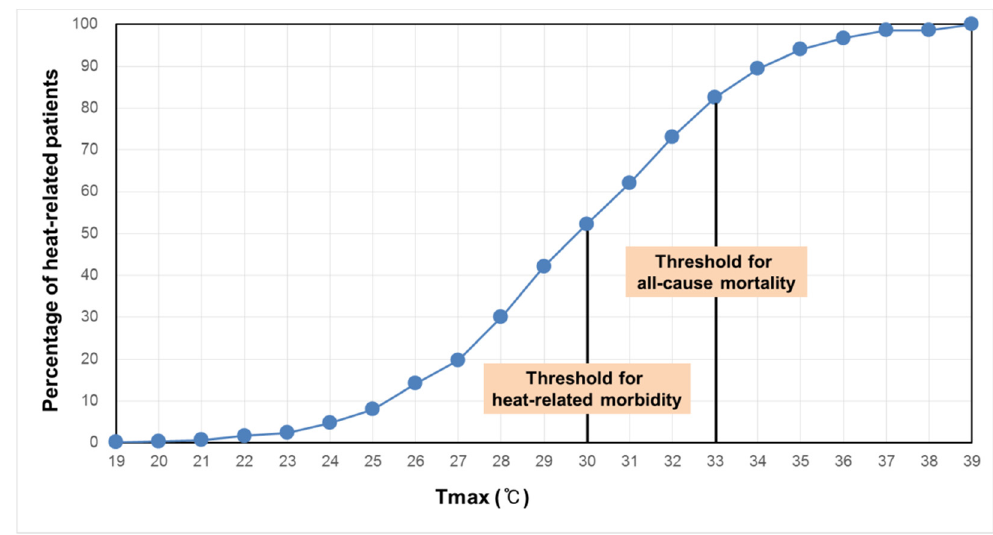
Figure 3. Cumulative number of heat-related morbidities with temperature increase.